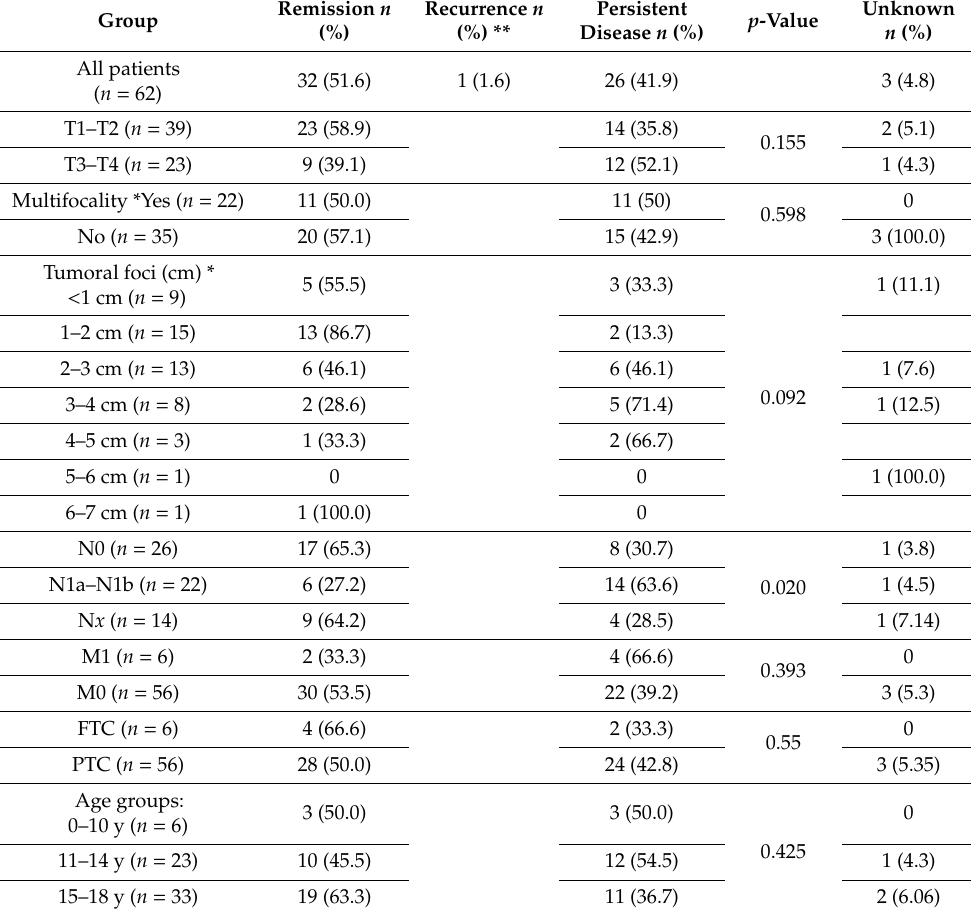
Figure 4. The distribution of the cumulative activity of 131-I administration (mCi/GBq). Table 6.